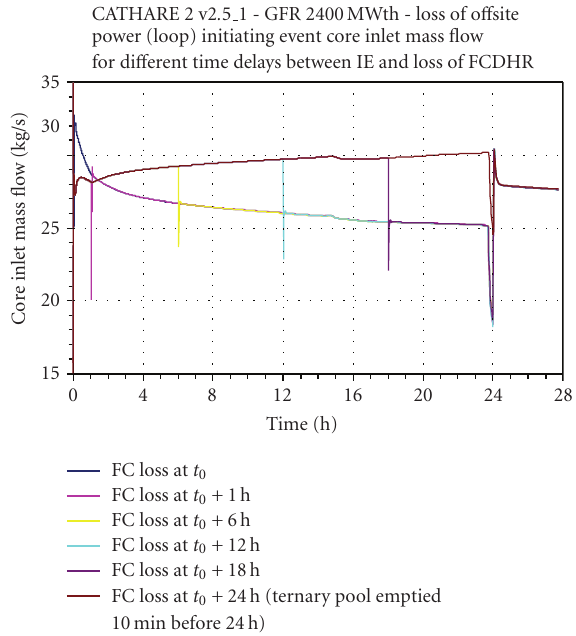
Figure 6: Influence of the time limit before NC actuation on the core inlet mass flow evolutions (1 DHR loop